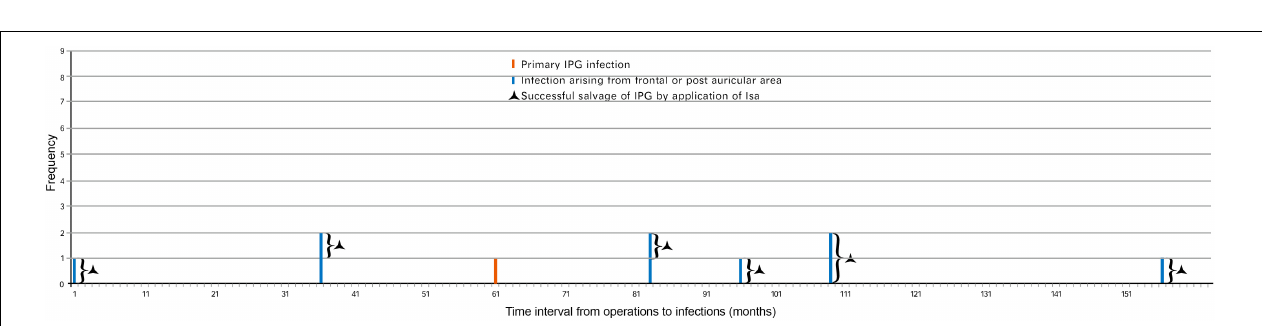
FIGURE 4 | The safe time window for the application of Isa. Thirteen cases of infection spread to IPG in group A including six originating from frontal while seven originating from postauricular area. Seven cases of infection in group B underwent Isa within the safe time window. Months and days: The interval of infection spreading from frontal to postauricular area counted in months and subsequently to infraclavicular region (IPG pocket) counted in days. Significant difference in the interval duration was reported between two sections (Wilcoxon signed-rank test, p = 0.025). IPG, implantable pulse generator.